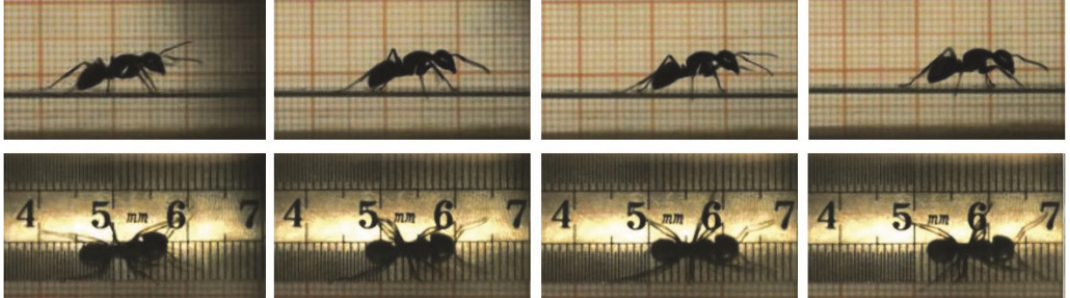
Figure 6: The left view and top view of sliding phase of leg R3.